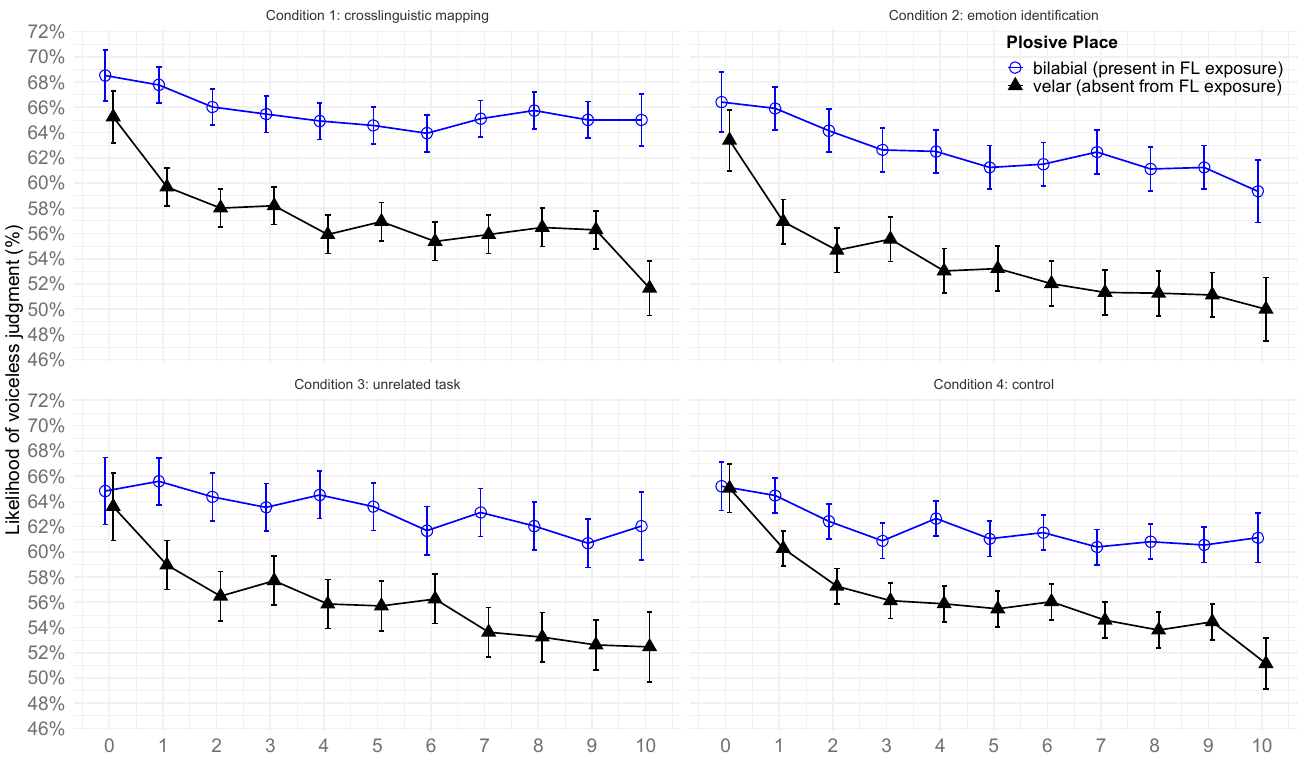
Figure 10. Likelihood of voiceless identification (averaged over post-test and pre-test), by task condition, number of audio exposures, and place of articulation. Error bars indicate standard error.